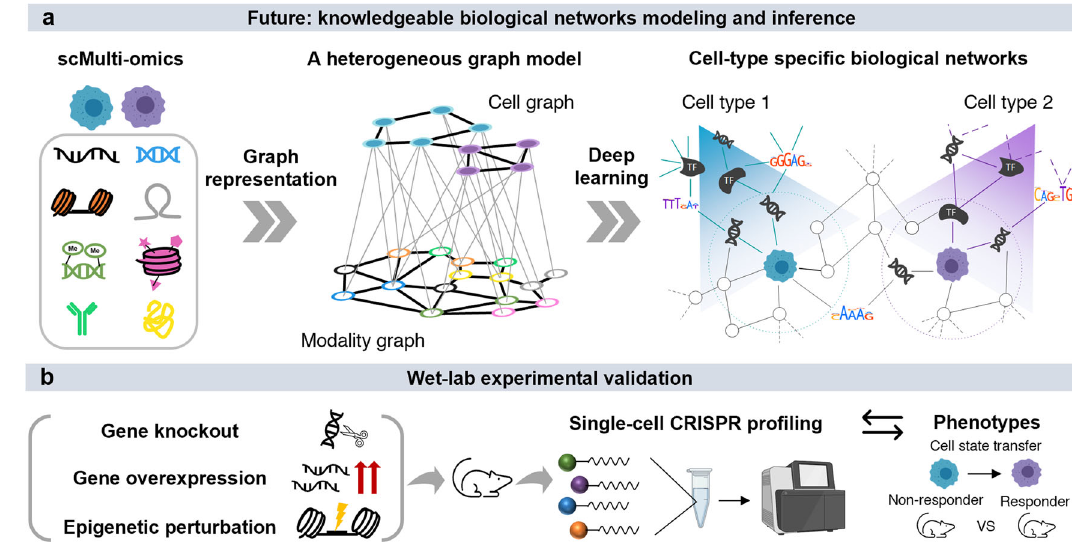
Fig. 2 Deep learning modeling and wet-lab validations for scMulti-omics data. a Heterogeneous graphs and deep learning models can enable sophisticated biological network inference from scMulti-omics data. b Wet-lab experimental validations bridge scMulti-omics predictive fi ndings with phenotype